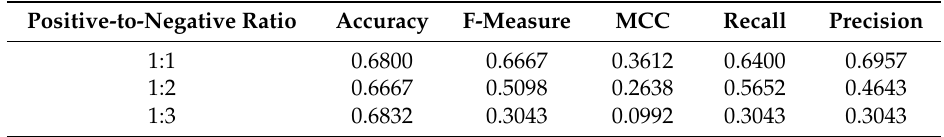
Table 1. The classification performance of different positive-to-negative sample ratios by using the feature of the side effect of drugs on the independent test.